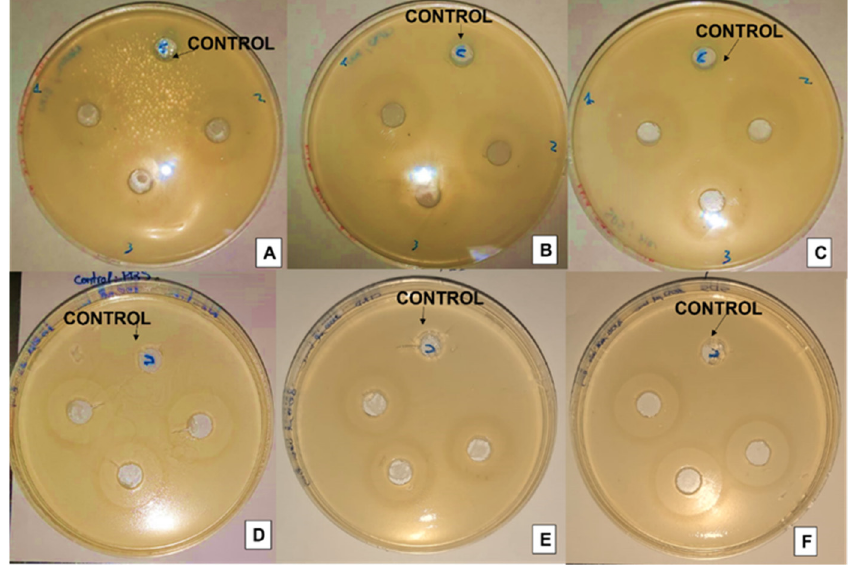
Figure 4. Time kill curves of each formulation of niosomes with and without vanillin compared to the control and free vanillin.